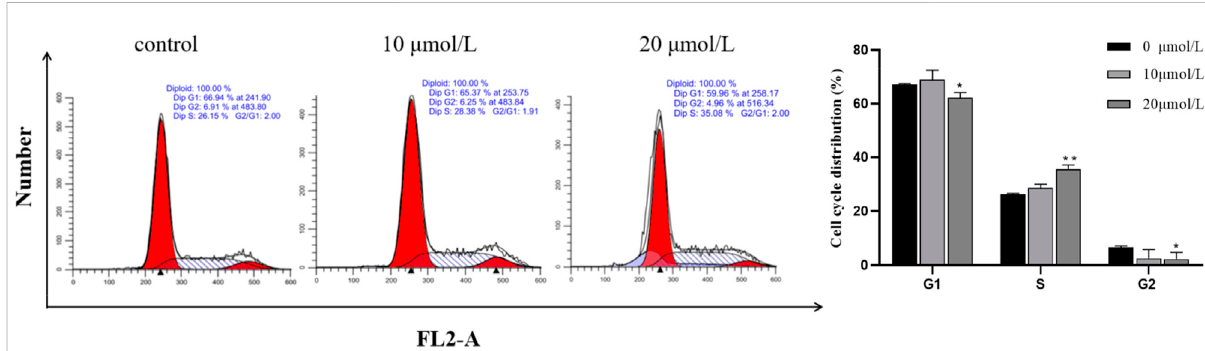
Effect of RFA on the cycle of 786-O cells. The proportion of cell numbers corresponding to the cell cycle (G1 phase, G2 phase, and S phase) in eachgroupaftertreatmentwithdifferentconcentrationsofRFAwasdemonstrated.Datawereexpressedasmean±SD.Thestatisticalmethodswere